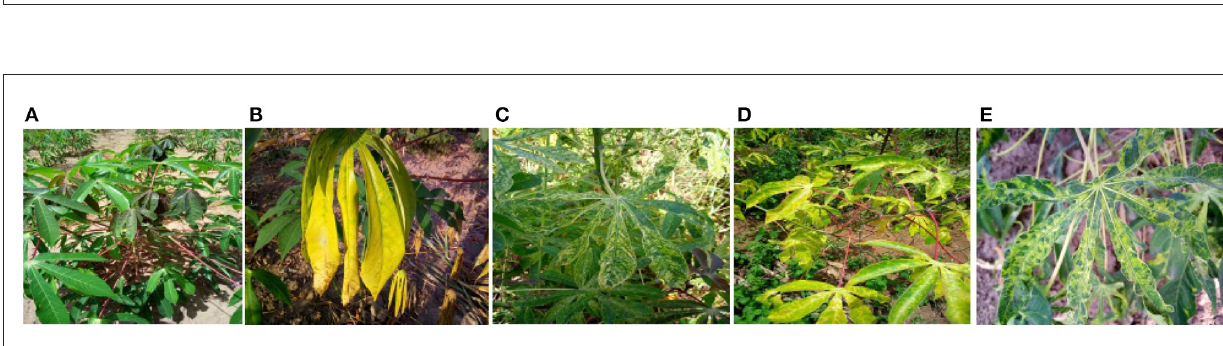
The BLEU score is a value that ranges between 0 and 1, measuring the similarity of a model answer to an expert